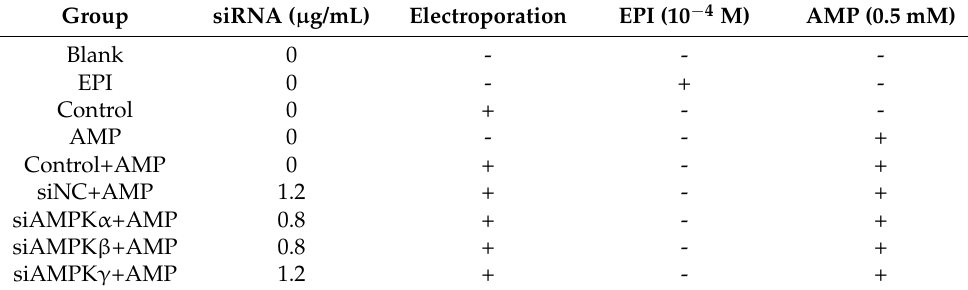
Table 4. The experimental groups